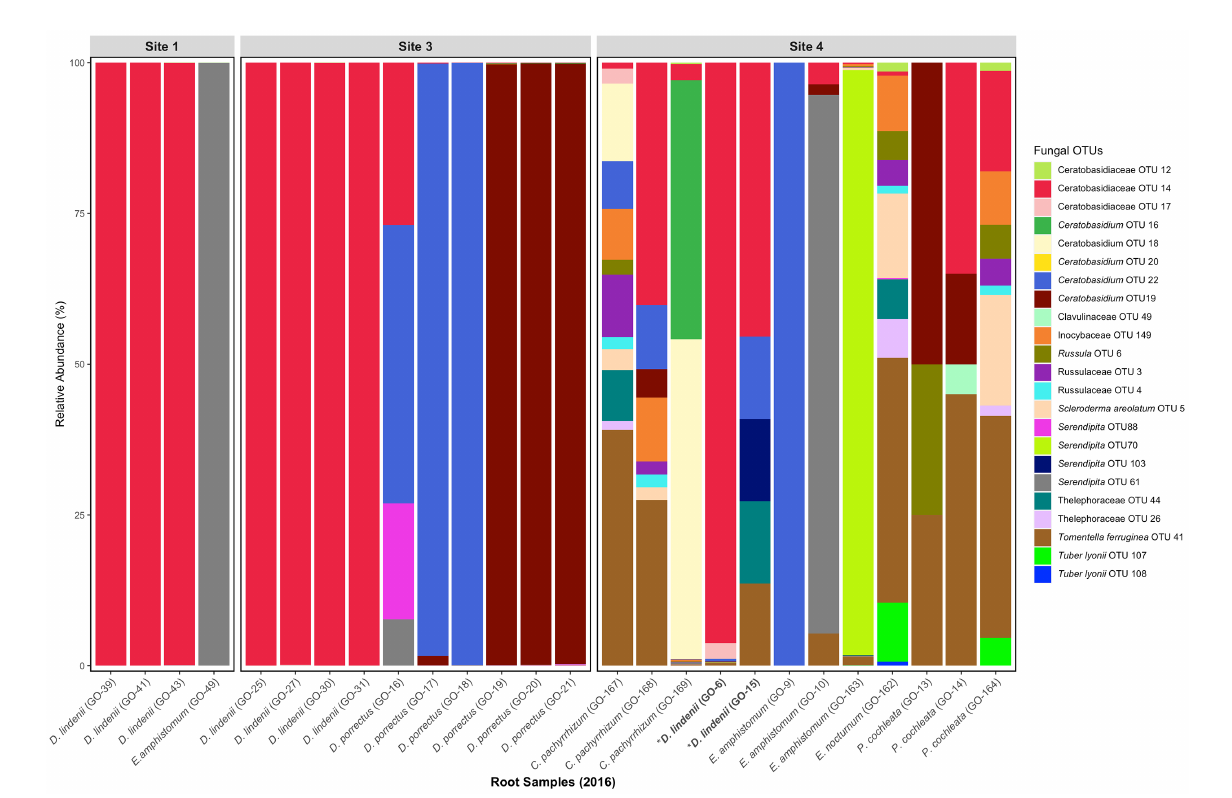
FIGURE 2 Relative abundance of fungal OTUs (putative OMF) obtained from root samples of D. lindenii and co-occurring epiphytic orchids in 2016. Dendrophylax lindenii explants at site 4 are bolded and are labeled with an